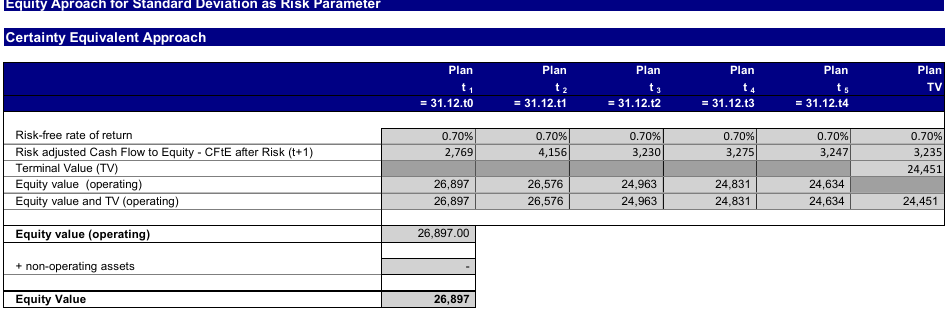
Figure 12. Calculation of the company value with the certainty equivalent method.